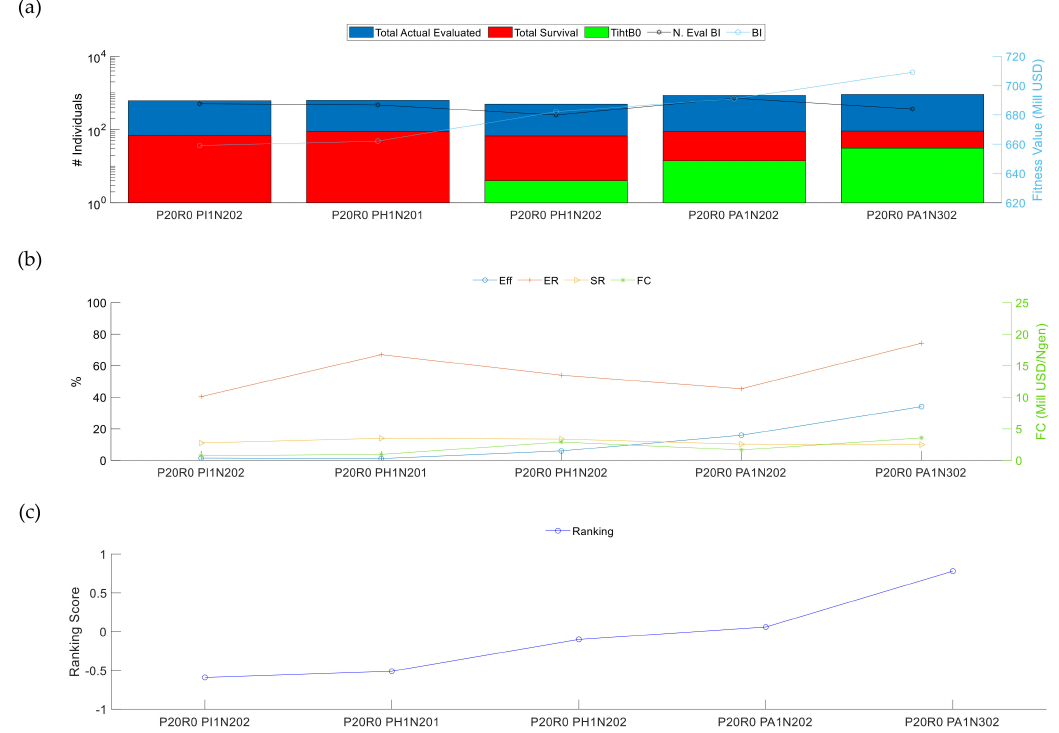
Figure 20. Summary of the performance indicators for analysis I, Section 1. ( a ) shows variables of KPI 3,4 and 5 in bar chart, KPI 1 and variable of KPI 7 in line chart, ( b ) shows KPI 3,4,5 and 6 in line chart, ( c ) shows the ranking score based on Table 8.